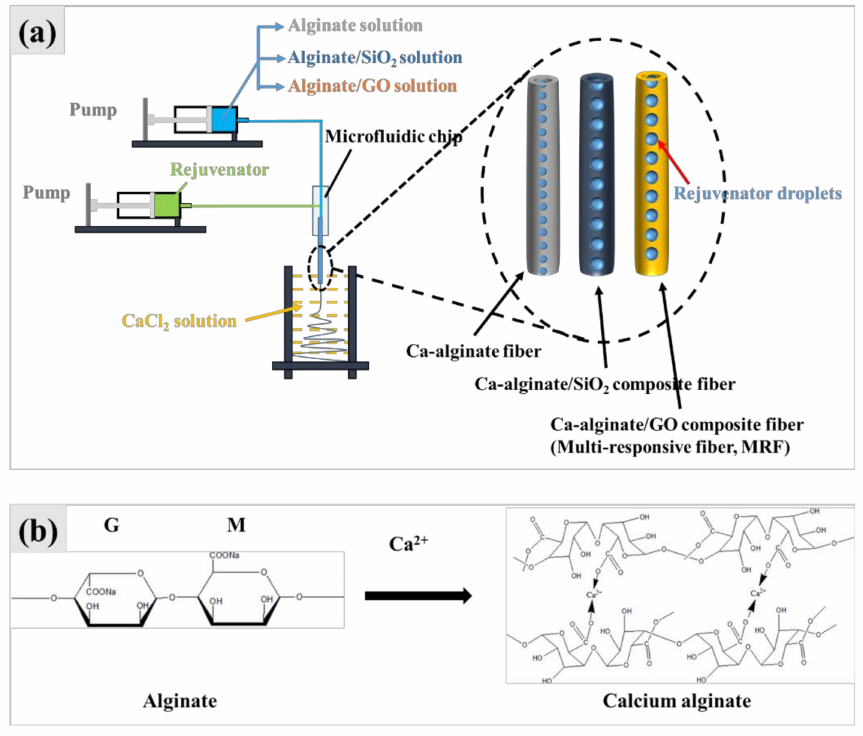
Figure 1. Synthesis process ( a ) and synthesis mechanism ( b ) of the three kinds of